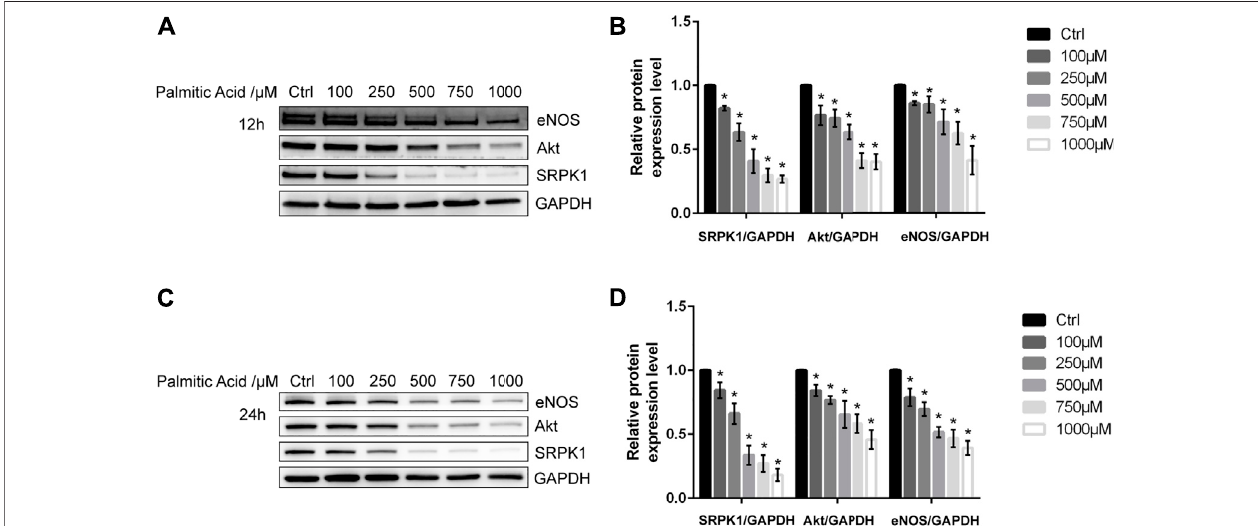
FIGURE1| SRPK1isdown-regulatedinendothelialdysfunctioninducedbyPA.HUVECsweretreatedwithdifferentconcentrationsofPA(100,250,500,750,and 1000 μ M)for12and24 h.ThelevelsoftheeNOS,AktandSRPK1weredeterminedbywesternblot (A,C) withthequanti fi cationsoftherelatedproteins (B,D) .Thedata arepresentedasthemean±SDofthreeindependentexperiments.Signi fi cancewasdeterminedbyone-wayANOVAwithaleastsigni fi cantdifferenceposthoctest.ns, p > 0.05; *, p < 0.05 vs Ctrl.